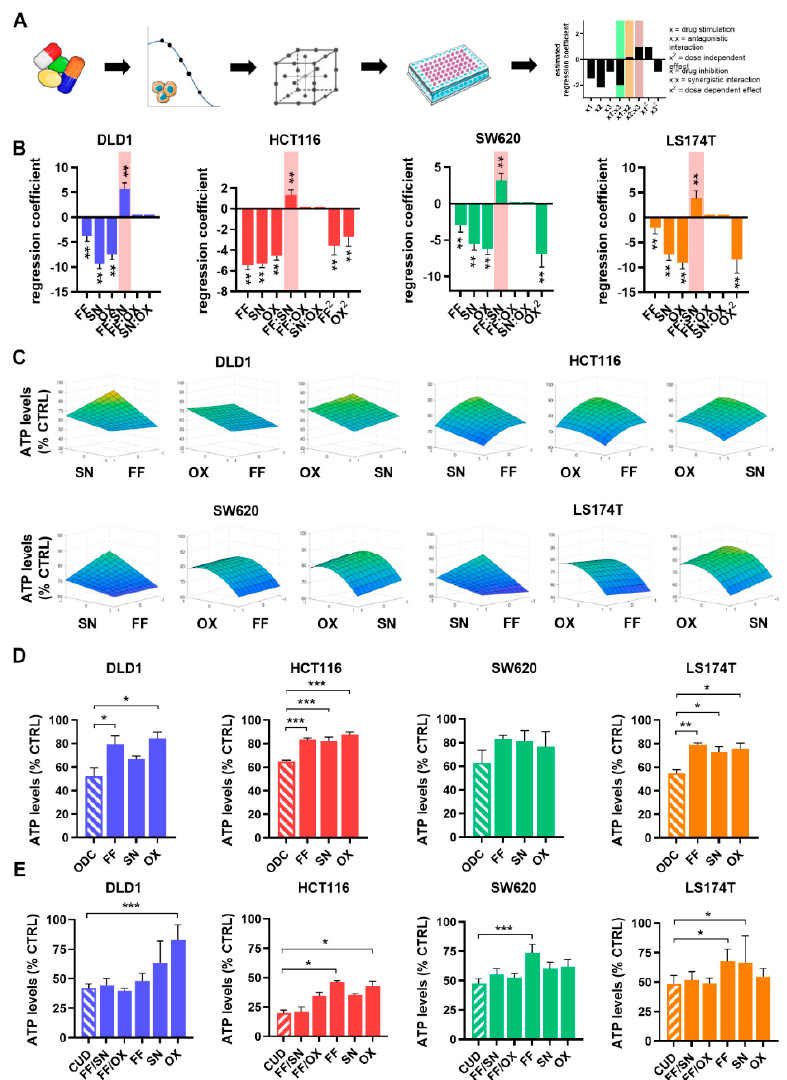
Figure 3. Optimization of low dose optimized drug combinations (ODCs) and validation of the clinically used doses (CUD) combination. ( A ) Schematic representation of the optimization process. Starting with the drugs, namely folinic acid and 5-fluorouracil combined (FF), SN-38 (SN) and oxaliplatin (OX), in the first step, drug dose-response curves were generated and low doses inhibiting with approximately 20% cell metabolic activity (ATP) were selected as drug dose input for the next step (FF, SN, OX). Drug combinations were screened according to a predefined orthogonal array composite design (OACD) matrix in cells seeded in 96-well plates and drug combination activity on cell metabolic activity was modeled based on step-wise second-order linear regression analysis. The models present regression coe ffi cients identifying the contribution of single-drug activity of each drug and drug-drug interactions contributing to the overall activity of the combination. ( B ) Stepwise second-order linear regression model depicting the regression coe ffi cients of the drugs composing the ODC at low doses for each of the cell lines, screened concomitantly (Schedule 1). ( C ) Response surface contour plots between FF, SN and OX, fitted with the regression coe ffi cients generated. The y -axis represents drug e ffi cacy (ATP levels, % CTRL), the x -axis represents the dose range (1, high dose, ED 20 ; 0, low dose, ED 10 ; − 1, no drug) for each drug. ( D ) E ffi cacy of drug combinations and corresponding monotherapies of the cell-specific ODCs and each monotherapy at an equal concentration as in the corresponding ODC. ( E ) The drug combinations at clinically used doses (CUD). Error bars represent the SD for N = 2–3 experiments and * p < 0.05, ** p < 0.01 and *** p < 0.001 represents the significance of estimated regression coe ffi cients ( B ) or the comparison with the full drug combination of N = 2–4 experiments ( D , E ) by a one-way ( B , D ) or two-way ANOVA ( E ) with post-hoc Dunnett’s multiple comparisons